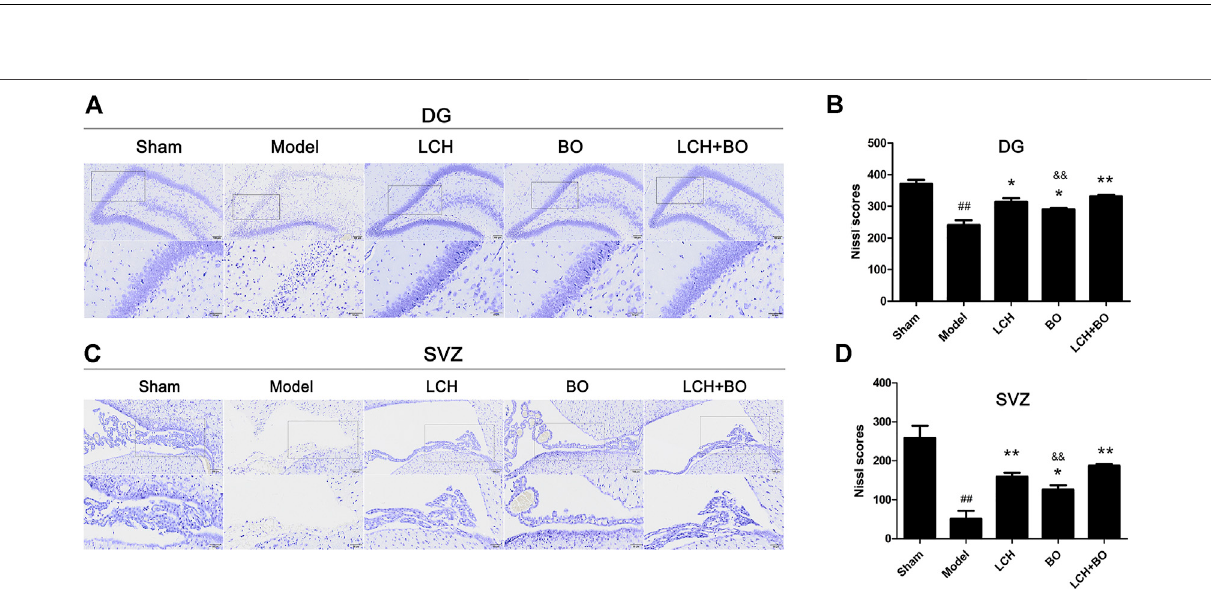
FIGURE2| NisslscoreswithinDGandSVZofMCAOrats. (A) RepresentativepicturesofNisslstainingintheDGarea. (B) TheresultsofNisslscoresintheDGarea ( n (cid:1) 3). (C) Representative pictures of Nissl staining in the SVZ area. (D) The results of Nissl scores in the SVZ area ( n (cid:1) 3). ## p < 0.01 compared to the sham group; * p < 0.05, ** p < 0.01 compared to the model group; && p < 0.01 compared to the LCH + BO